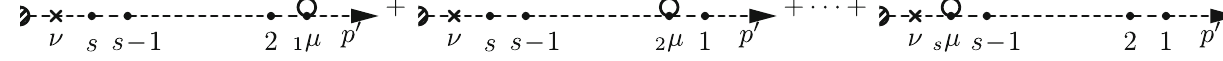
Fig. 7 The diagrams with only μ vertices circled that belong to set II